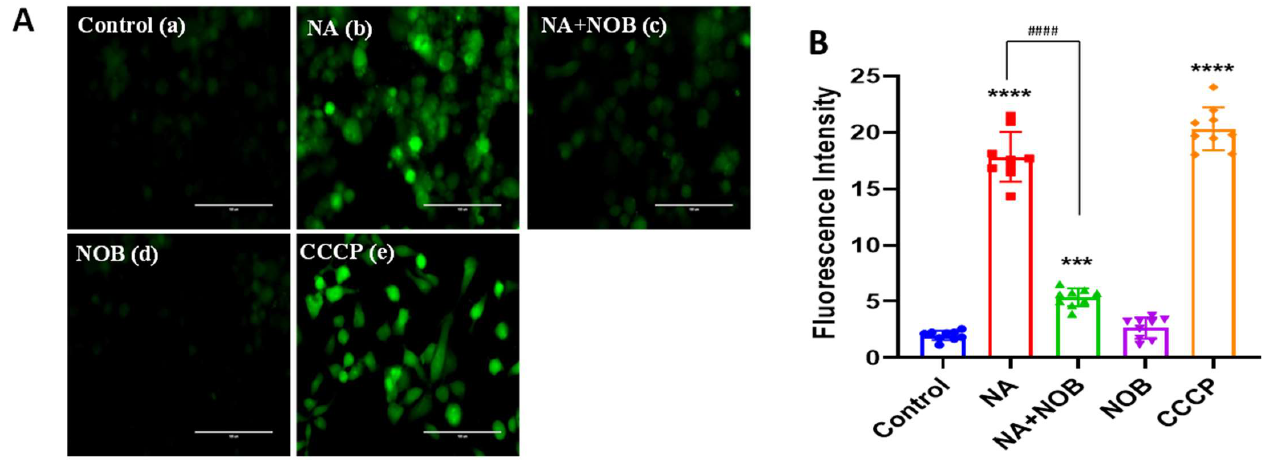
Figure 3. Detection of ROS generation by DCFDA in hNPCs ( A ) ( a ) Control or unexposed cells, ( b ) NA-exposed cells, ( c ) NA and NOB co-exposed group, ( d ) NOB exposed cells, and ( e ) Positive control group exposed to CCCP. Images were taken with Invitrogen EVOS FL fluorescence microscope. Scale bar, 100 μM. ( B ) Graphical representation of ROS generation following the different groups of exposures. Cellular and mitochondrial ROS generation was calculated by ImageJ software. Data are represented as mean ± SEM of three separate experiment replicates performed in n = 3 (biological replicates); the significant changes in comparison to the unexposed control group are *** p < 0.001, **** p < 0.0001, and #### p < 0.0001 compared with NA-exposed cells.